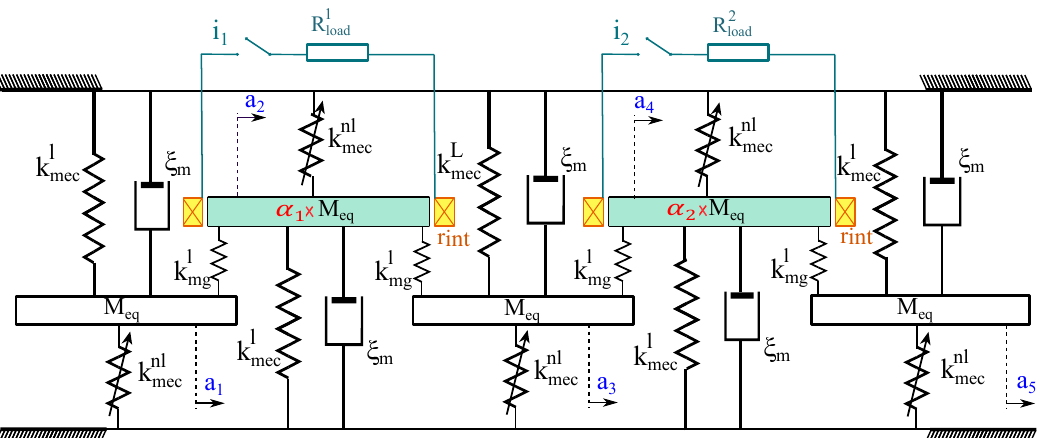
Figure 6. The equivalent 5-DOFs model of the vibration energy harvester